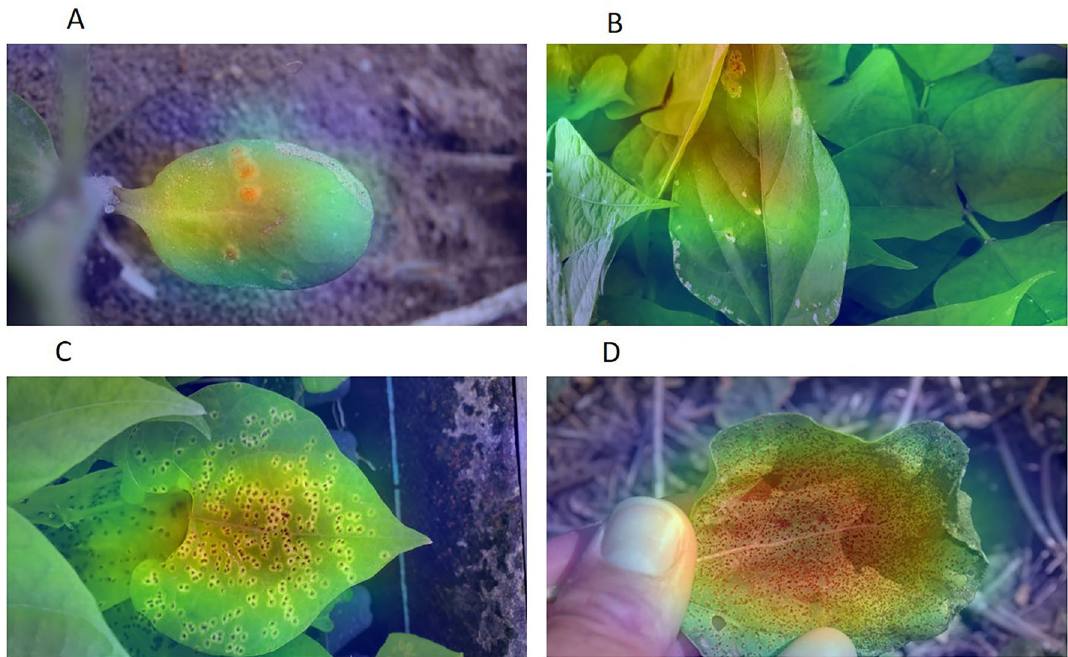
Figure 3. Heat map generated using Gradient-weighted Class Activation Mapping (Grad-CAM) method. The red and blue regions highlight the most and the least discriminative regions, respectively. ( A ) field pea, ( B ) and ( C ) dry bean, and ( D )